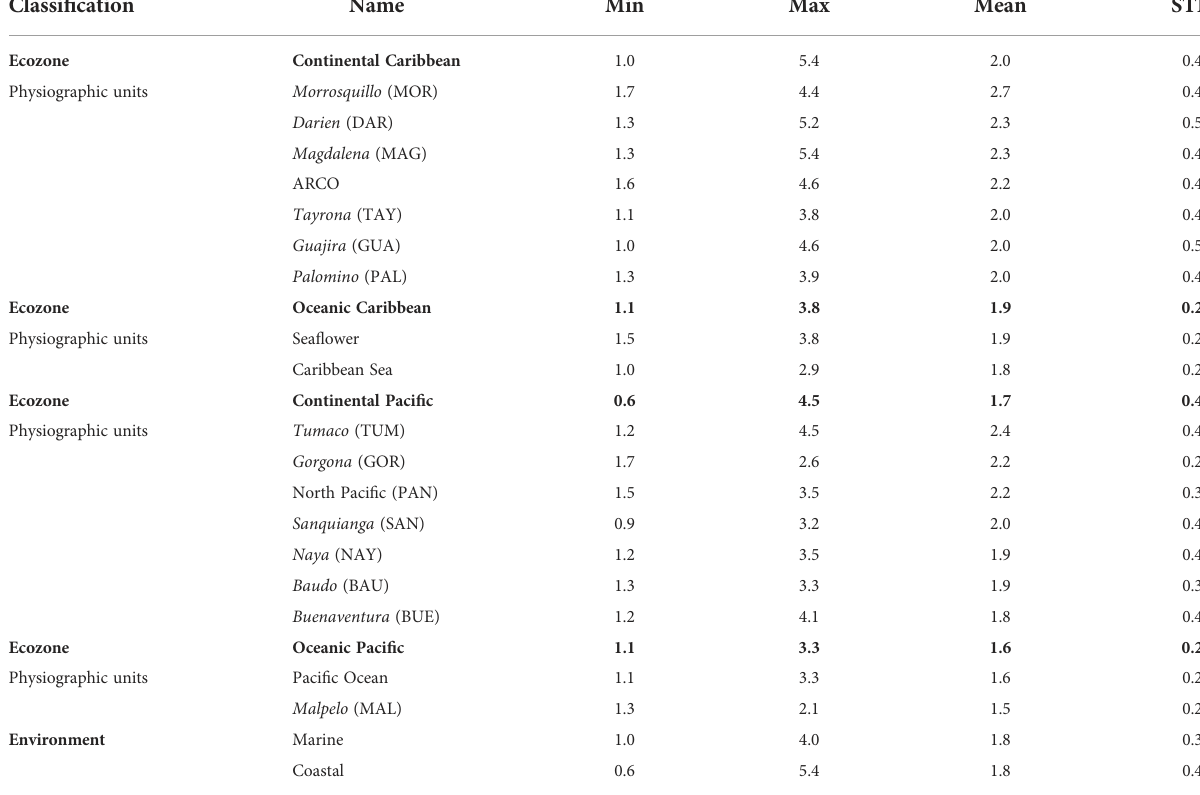
TABLE 4 Threat level by ecozone and